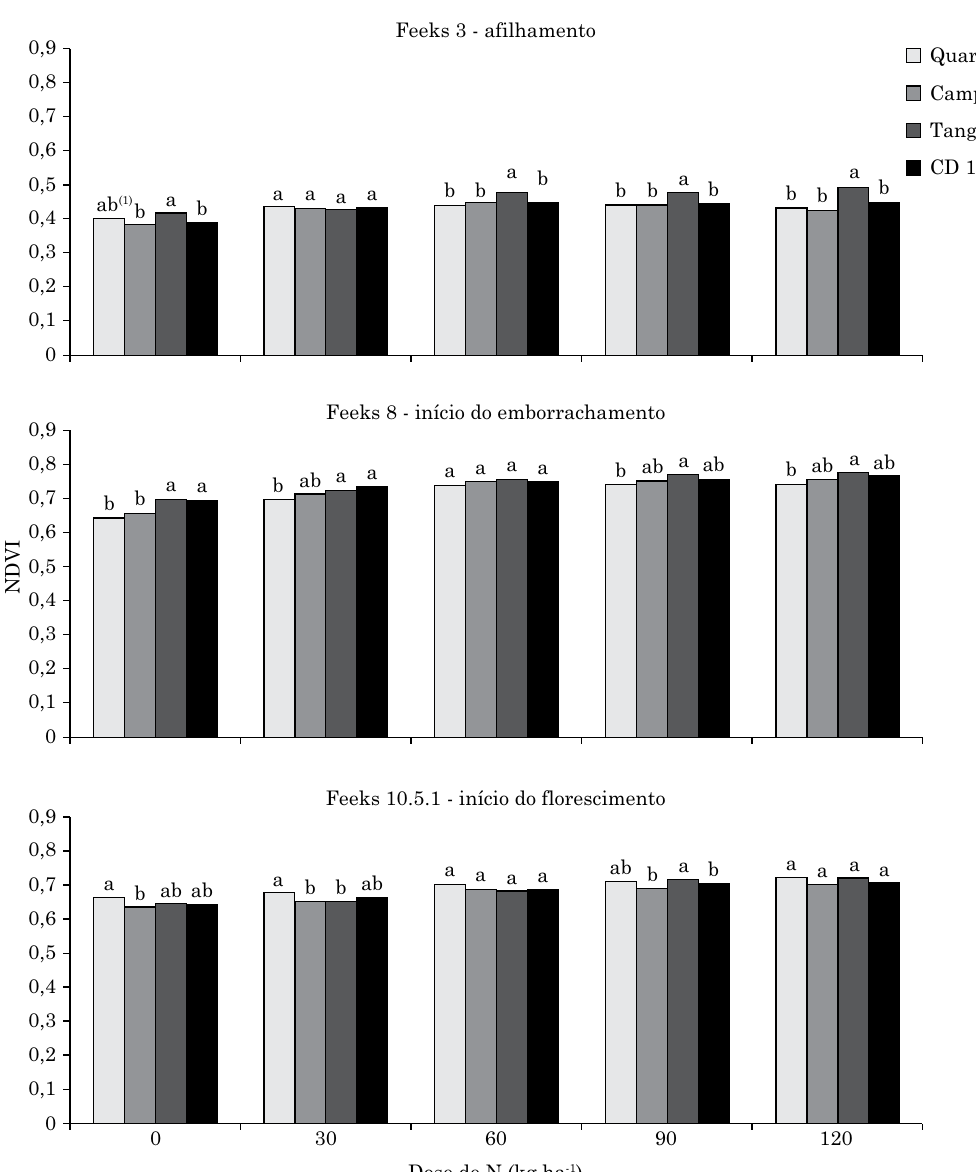
figura 2. Índices de vegetação por diferença normalizada (ndVi) obtidos pelo sensor ativo, das cultivares de trigo em razão das doses de nitrogênio (n), nos distintos estádios fenológicos. letras comparam cultivares para cada dose de n, em cada estádio fenológico, pelo teste tukey a 5